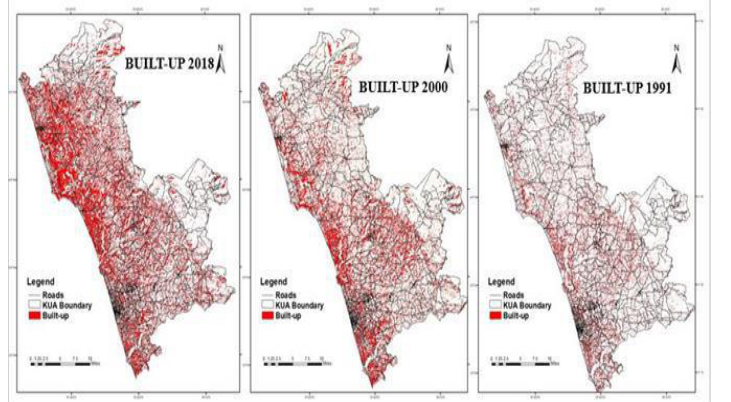
Figure 4: Built-up area map of 2018, 2000 and 1991 derived from